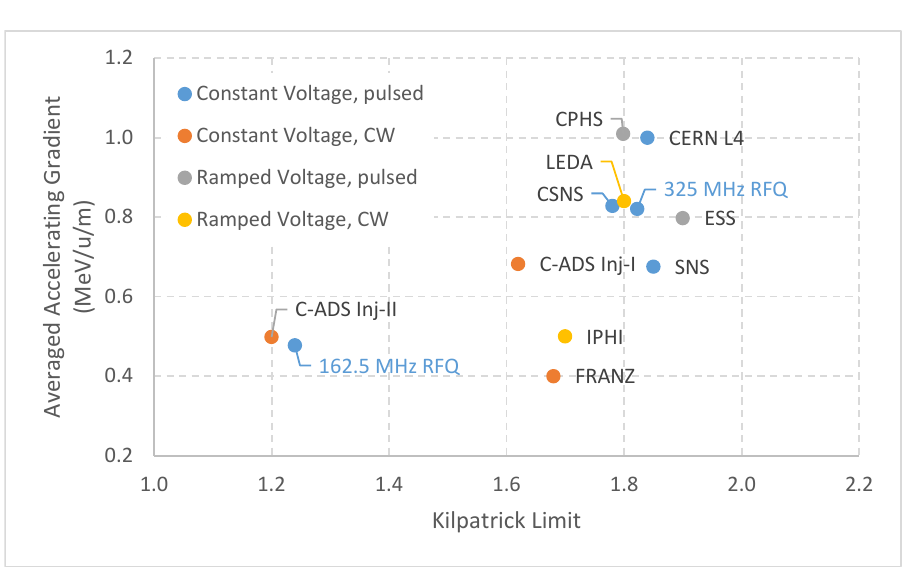
Figure 3. Energy gain per nucleon and Kilpatrick limit of various proton RFQs in the world.